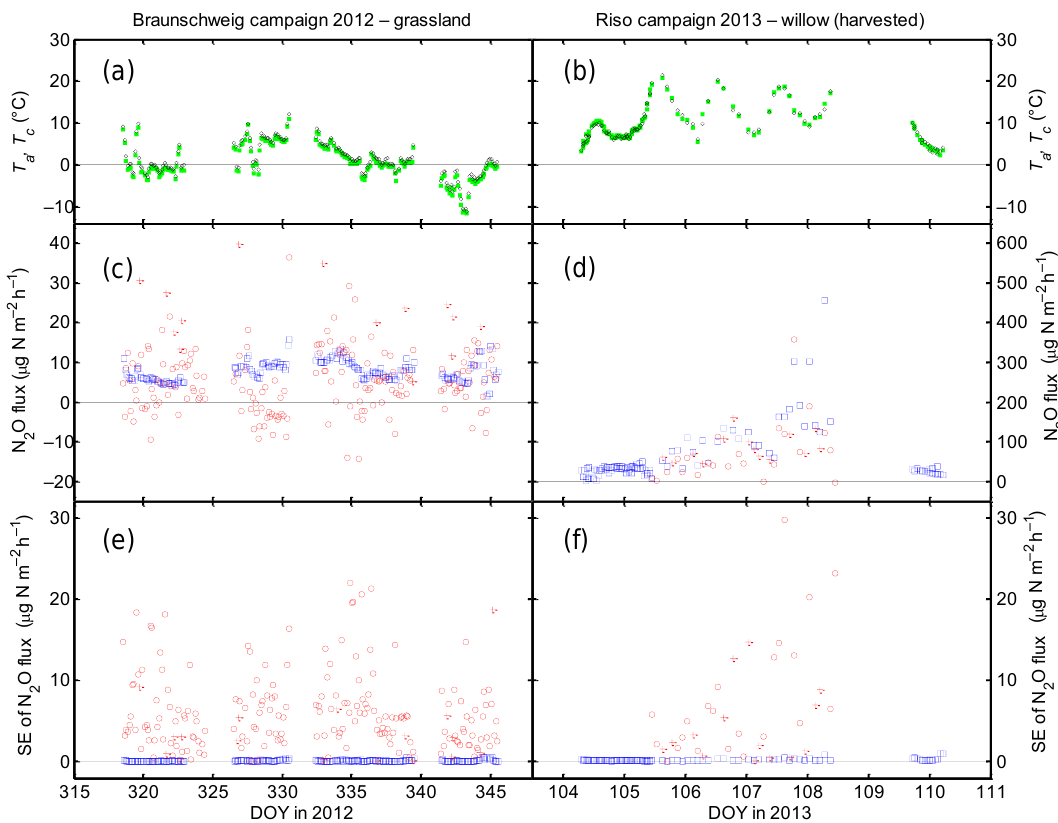
Figure 6. Time series of air ( T a , green markers) and chamber temperatures ( T c , black markers) (a, b) , N 2 O fluxes and the respective standard errors of N 2 O fluxes, during the Braunschweig (c, e) and the Risø campaign (d, f) . Blue markers indicate QCL data; red markers indicate GC data. Crosses are plotted for GC data when all criteria for flux calculation using the exponential HMR model were met (see text for details); otherwise circles are plotted indicating the usage of a linear model for flux